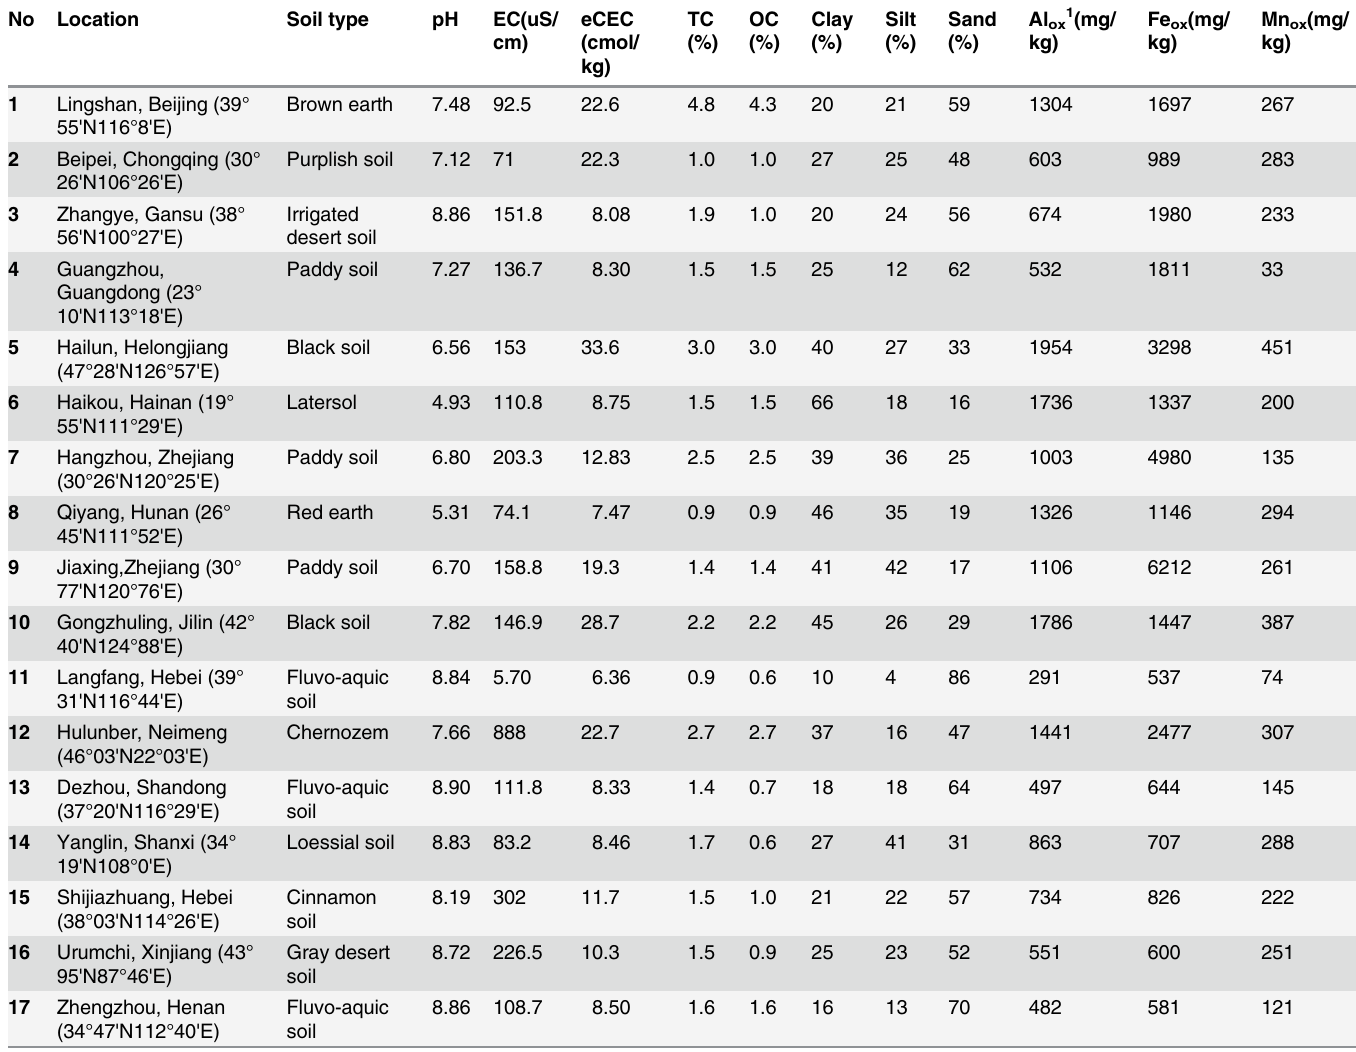
Table 1. The locations and main properties of soils used in the present